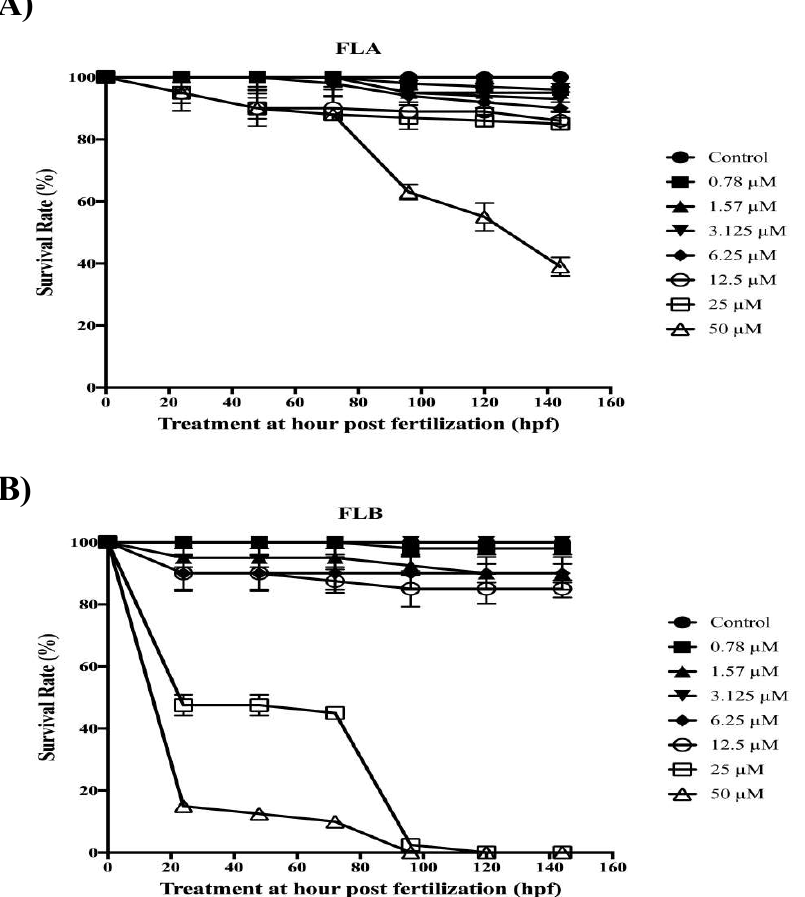
Figure 5. Toxicity e ff ect of chalcone derivatives on zebrafish embryos. Embryos were incubated in seven di ff erent concentrations (0.78 µ M–50 µ M) of ( A ) FLA and ( B ) FLB. Control was set as embryos treated in embryo media with 0.1% DMSO. The survival rates were recorded every 24 h until 144 h by using inverted microscope (Nikon TS100). Twelve fertilized eggs at 9 h post fertilization were selected for each concentration tested and control. Each value in the table is represented as mean ± S.E.M ( n = 4).